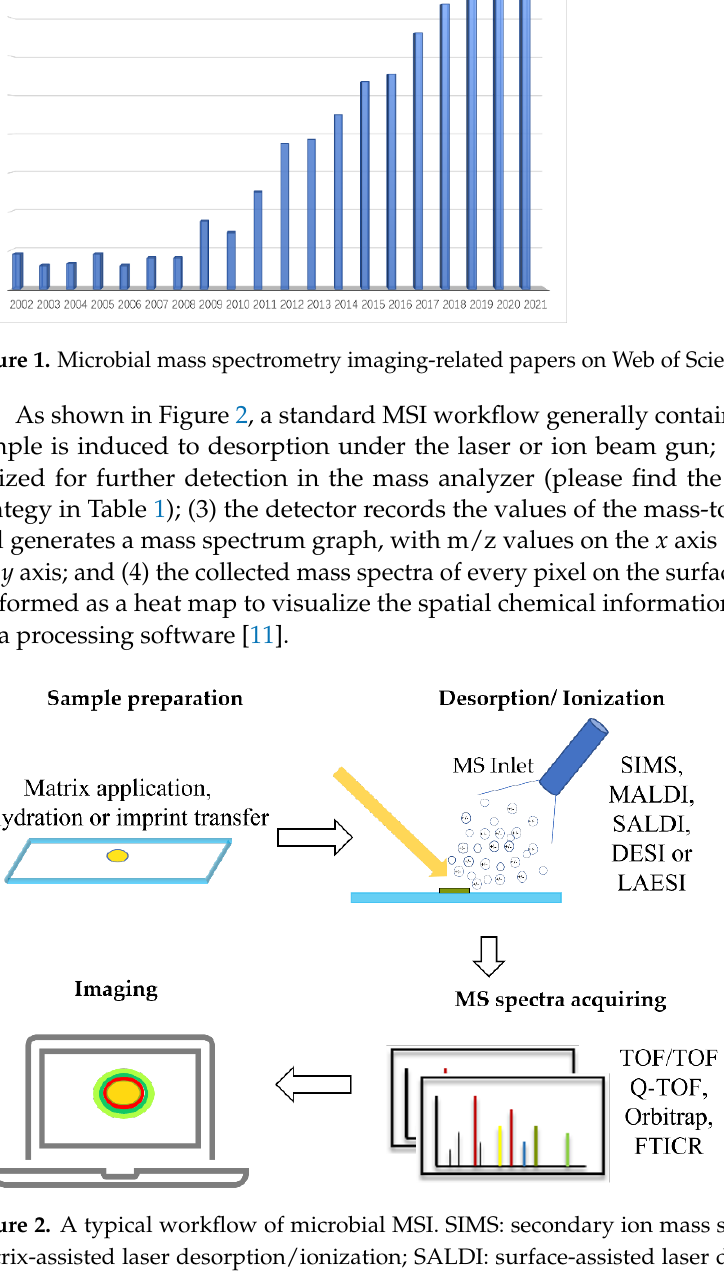
Figure 2. A typical workflow of microbial MSI. SIMS: secondary ion mass spectrometry; MALDI: matrix-assisted laser desorption/ionization; SALDI: surface-assisted laser desorption/ionization; DESI: desorption electrospray ionization; LAESI: laser ablation electrospray ionization; TOF: time-of-flight, Q-TOF: quadrupole time-of-flight, FTICR: Fourier transform ion cyclotron resonance.